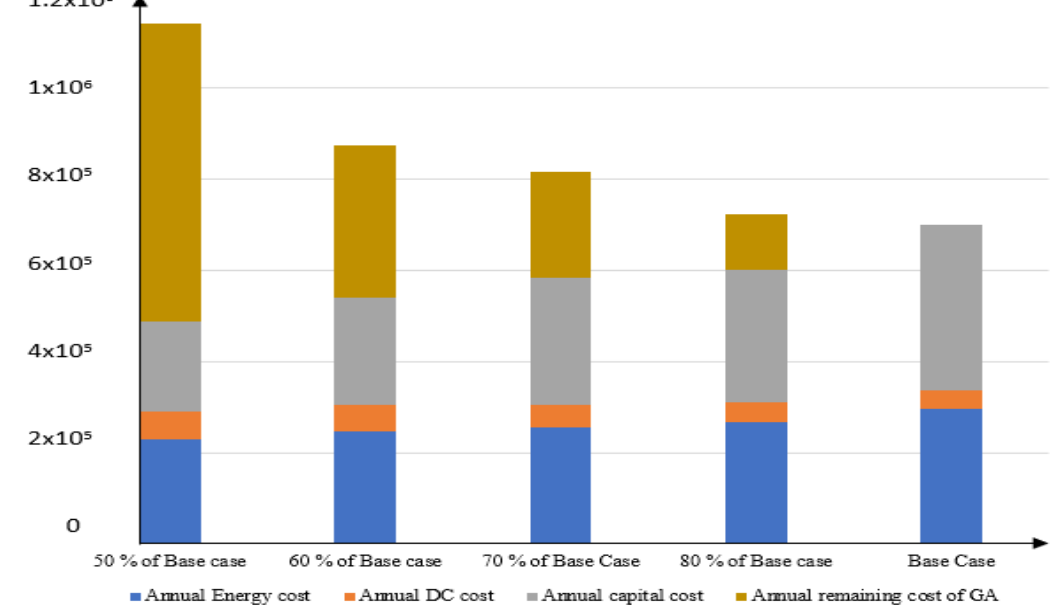
Figure 9. Results of available purchasing budget sensitivity case study in terms of the cost components.